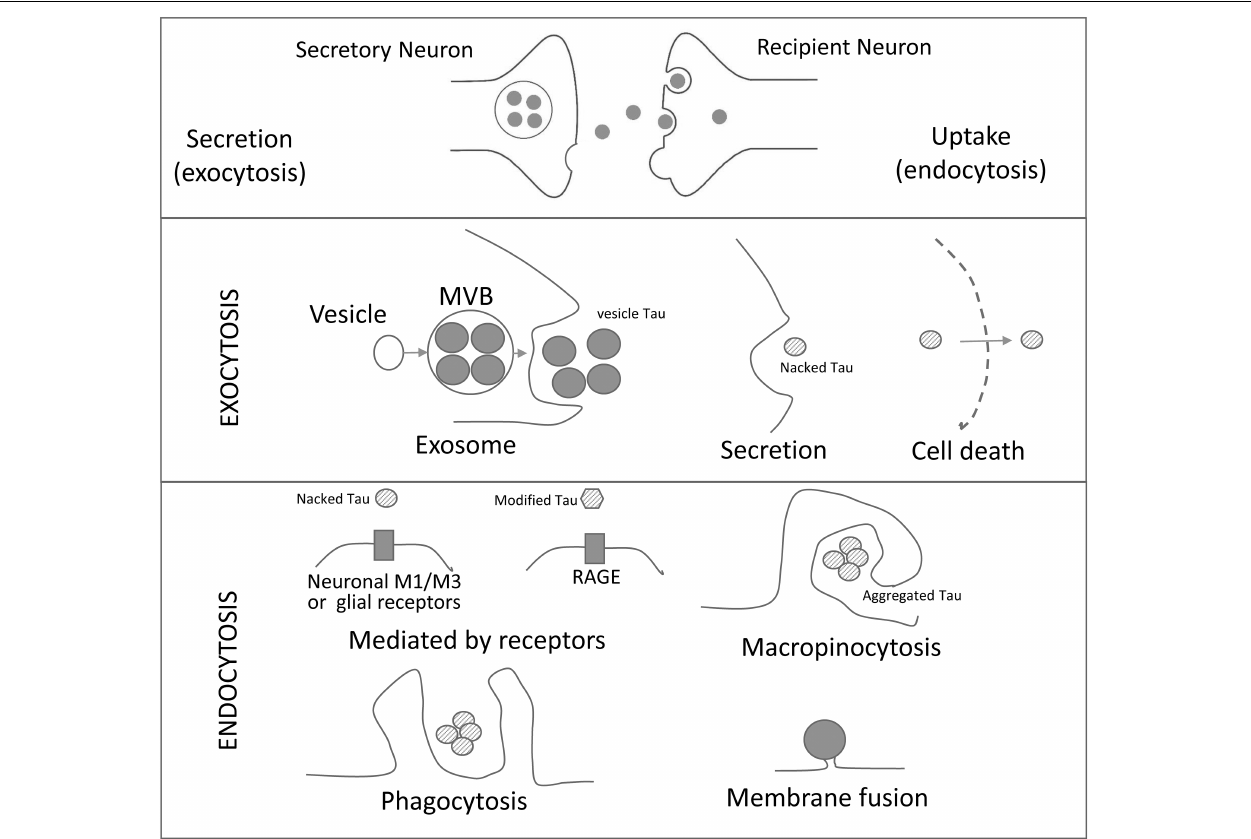
FIGURE 1 | Schematic Representation of Cell-to-Cell Transmission of Tau Pathology. Tau seeds are released from neurons by different exocytosic mechanisms (exosome, secretion and neuronal death). The released tau is taken up by neurons or glial cells by a variety of mechanisms (mediated by receptors, micropinocytosis, phagocytosis and/or membrane fusion of exosomes. RAGE: receptor for advanced glycation endproducts. M1/M3: muscarinic receptors.